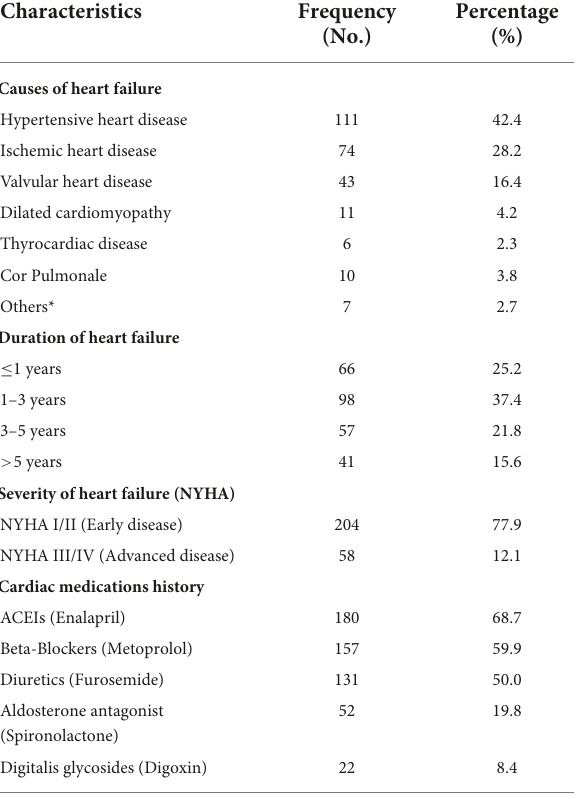
TABLE 2 Clinical characteristics of older adult patients with heart failure at Cardiac Clinic, University of Gondar hospital, June 01, 2021 to October 31, 2021 (No.